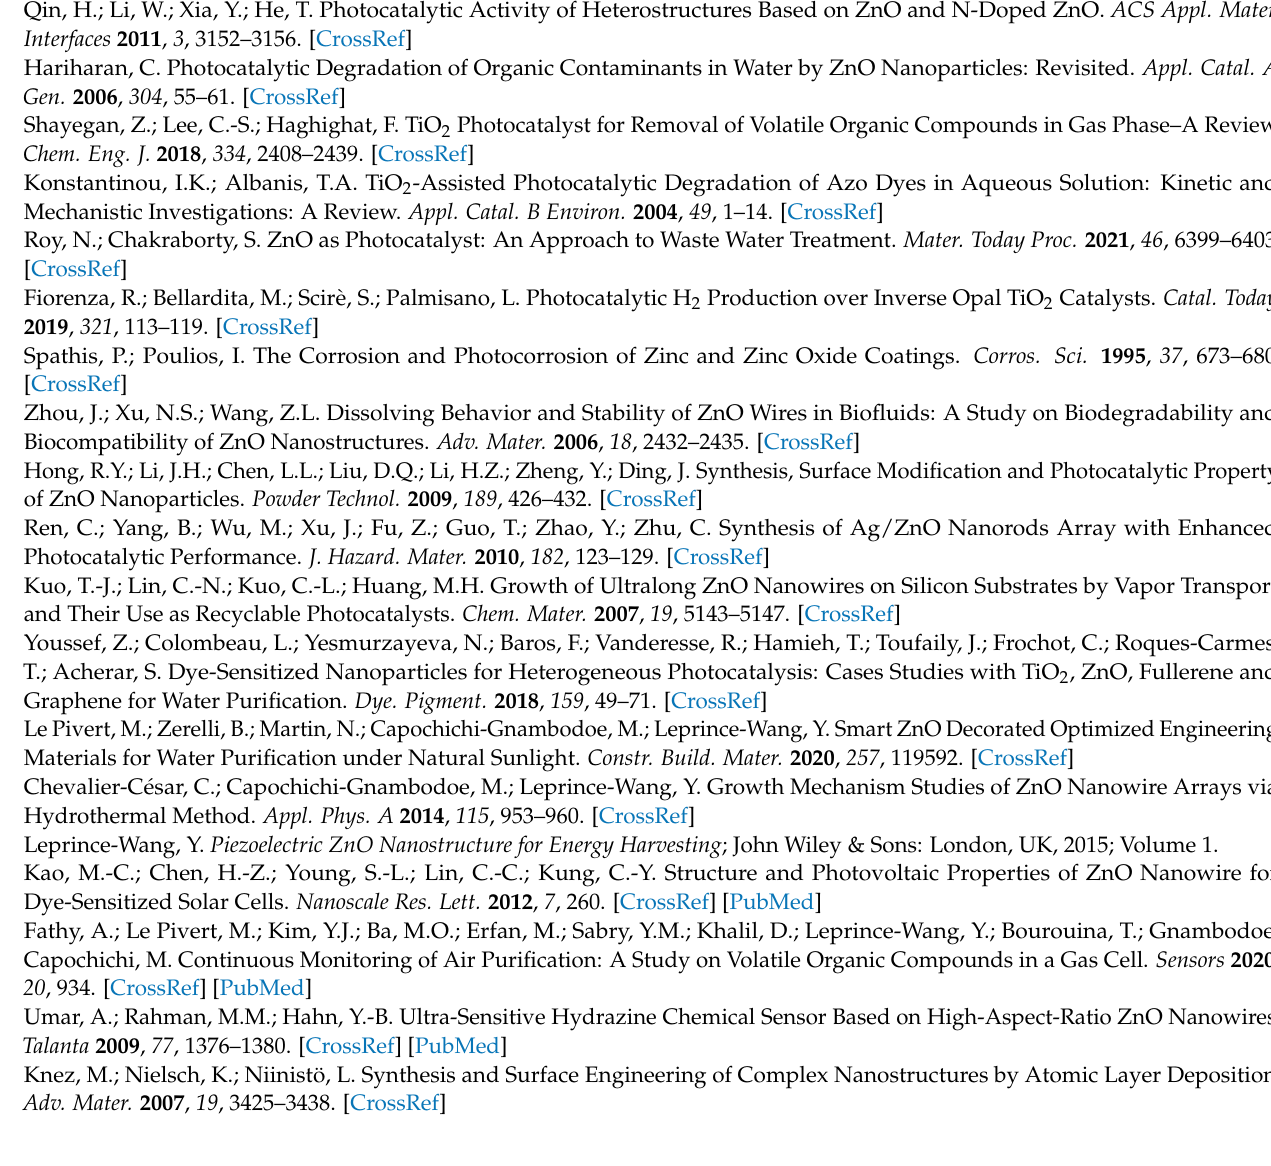
Figure S2: Effect of pH aqueous solution on bare ZnO NWs and 10 nm TiO 2 -coated ZnO NWs, Figure S3: UV-Vis spectra recorded during MB photocatalysis degradation. (a) Bare ZnO NWs, Figure S5: The photoluminescence spectrum comparison before and after vacuum annealing at 500 ◦